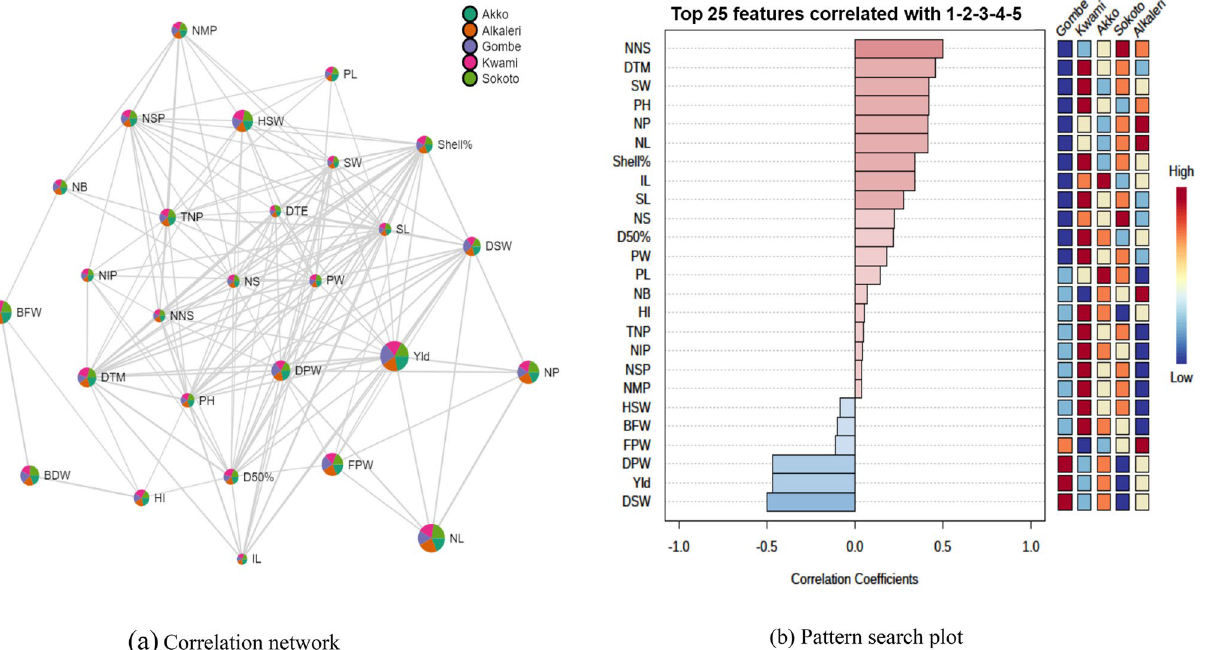
Figure 4. (a) Correlation network illustrates the relationship of 27 quantitative descriptors with five geographic population. Each node represents 5 geographic population of BG with five defined color and each edge represent the correlation between the two traits. (b) Pattern search plot insight into the correlation abundance of top 25 traits of respective five (1 = Gombe; 2 = Kwami; 3 = Akko; 4 = Sokoto; 5 = Alkaleri) Bambara ground nut population. Days to emergence = DTE (day), days to 50% flowering = D50%F (day), days to maturity = DTM (day), plant height (cm) = PH, number of branches per plant = NB, number of stems per plant = NS, number of petioles per plant = NP, number of leaves per plant = NL, no. of nodes per stem = NNS, inter nodes length = IL (cm), biomass fresh weight per plant = BFW(g), biomass dry weight per plant = BDW(g), total no. of pods per plant = TNP, number of mature pods per plant = NMP, number of Immature pods per plant = NIP, fresh pods weight = FPW(g), dry pods weight = DPW(g), pod length = PL(mm), PW = PW (mm), number of seeds